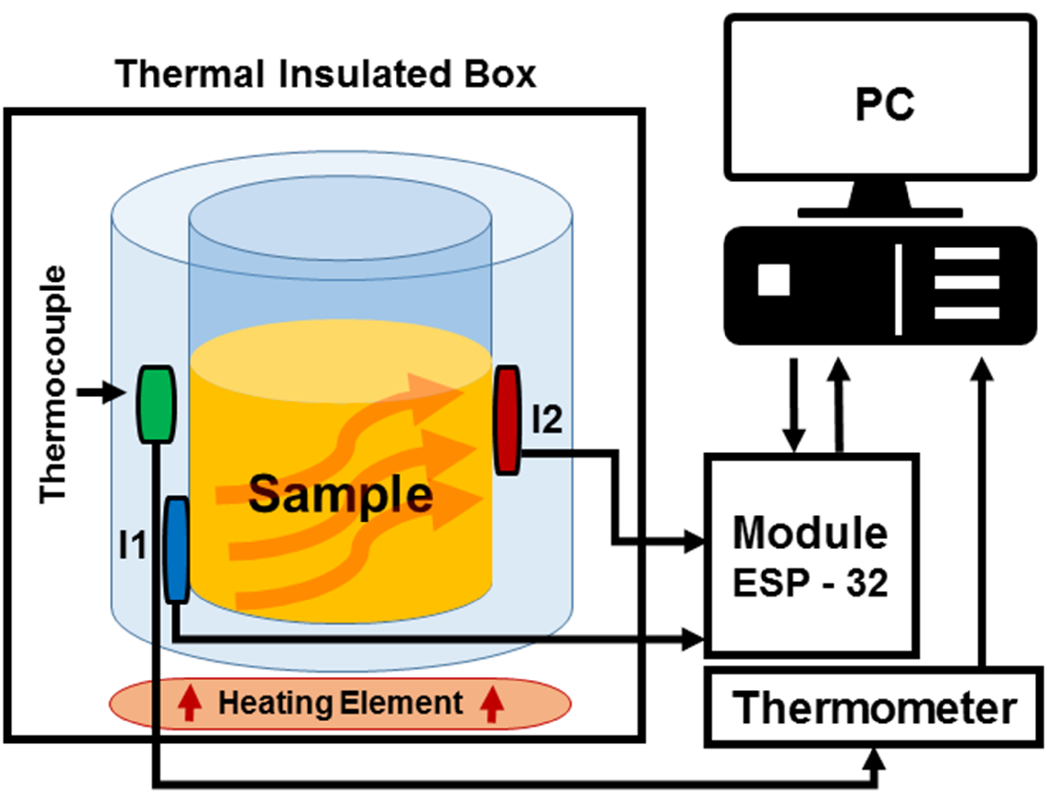
Figure 2. The scheme of construction of the thermodynamic system with the experimental device.